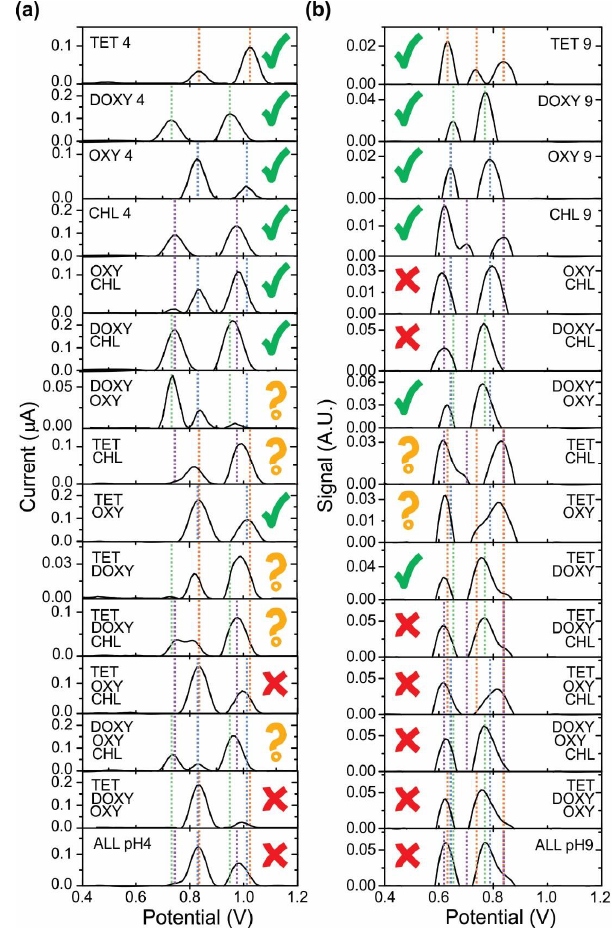
Figure 6. Electrochemical fingerprint of TCs in all type of combinations and mixtures at ( a ) pH 4, SWVs raw data (moving average correction) and ( b ) pH 9, output signal after the application of the script. The successful recognition of the TC is represented in the figure with a green tick ( by an orange question mark ( ? ) or a red cross ( X ) for inconclusive and unsuccessful identifications,